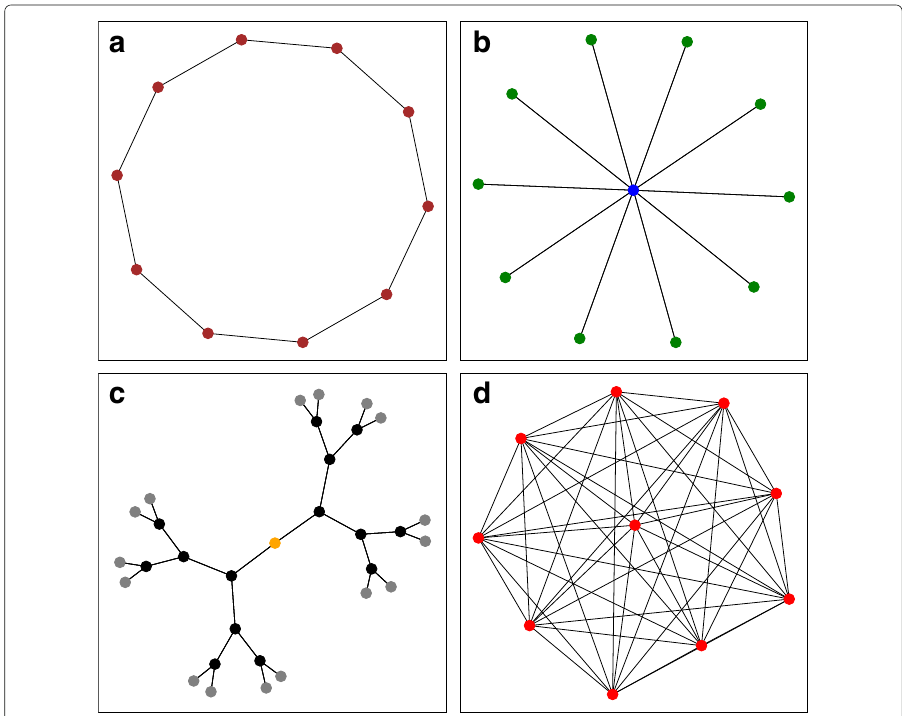
Fig. 4 Four network topologies. We used ( a ) a ring graph with ten nodes inside, ( b ) a star graph with ten peripheral nodes, ( c ) a complete binary tree graph with a height of four, and ( d ) a complete graph as a mesh graph. Each node role is colored based on its structural similarity